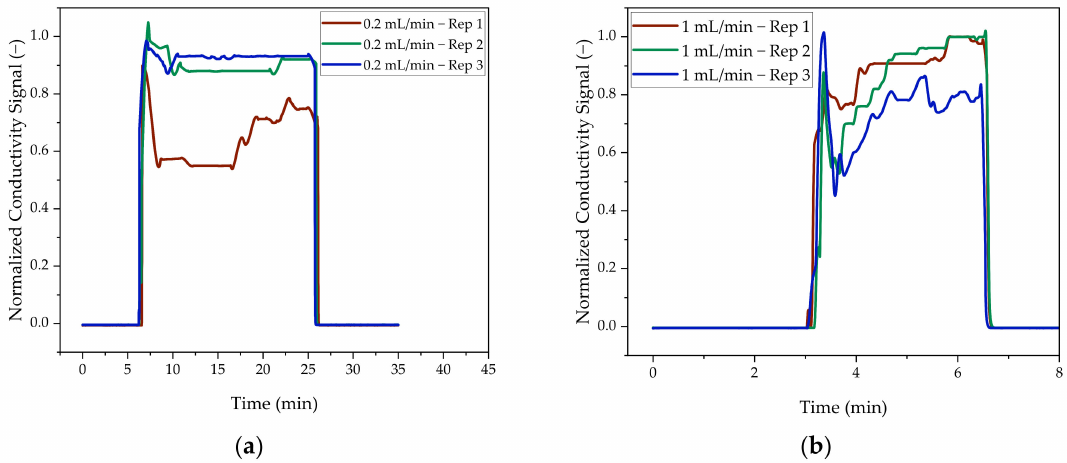
Figure 10. Normalized input signal of the slug. Recorded with a conductivity detector at a flow rate of ( a ) 0.2 mL/min and ( b ) 1